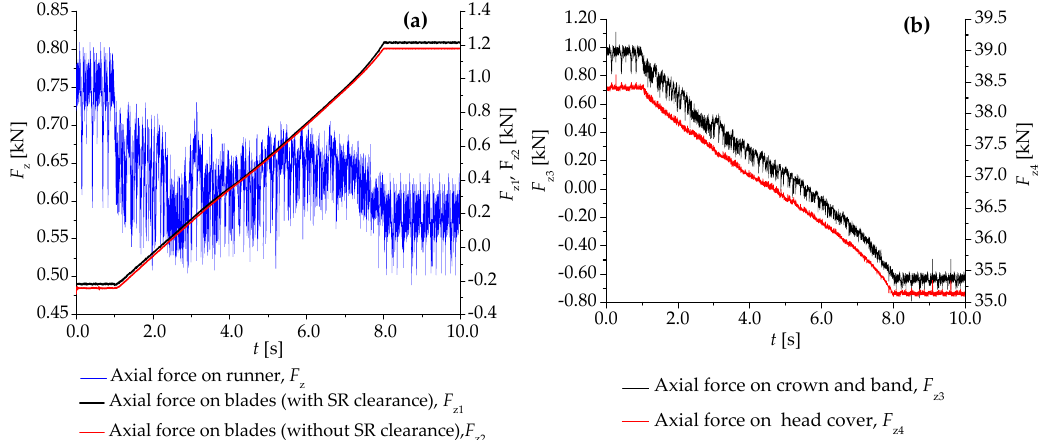
Figure 9. Numerical simulation of the axial forces on the runner, blades, and head cover of the Francis turbine under a load rejection condition. ( a ) Total axial water thrust on the blades and runner; and, ( b ) Axial forces on the crown and band/head cover.